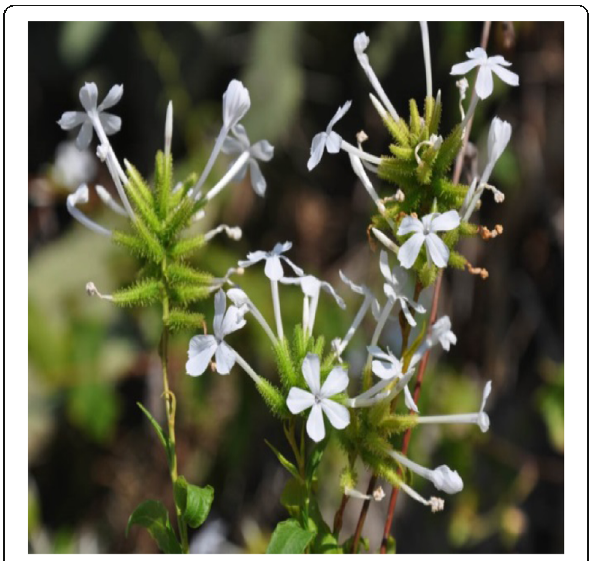
Fig. 10 Plumbago zeylanica . This endangered species belongs to the plant family Plumbaginaceae (Copy source Jacob Thomas